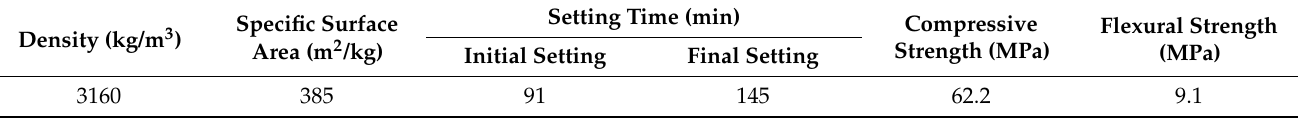
Table 1. The performance index of